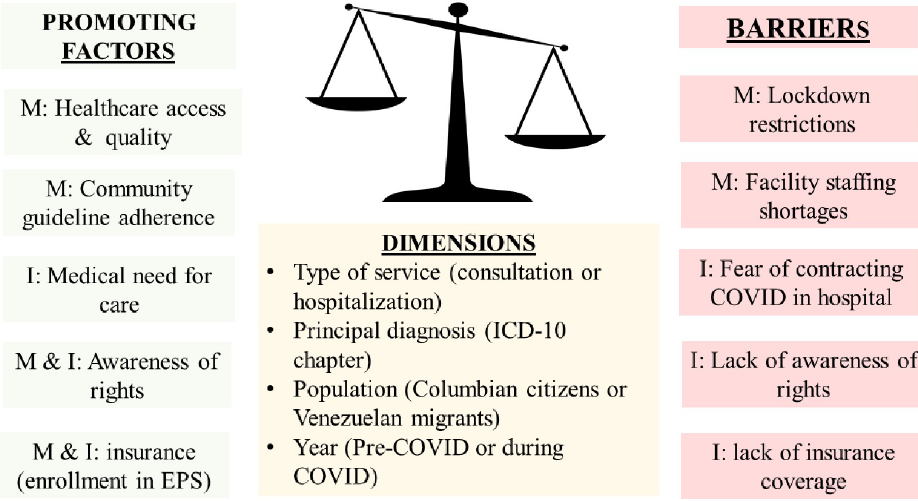
Fig 1. Conceptual framework: Utilization of medical services in Colombia: A balance. Notes: M denotes municipality; I denotes individual; ICD denotes International Classification of Diseases; COVID denotes corona virus